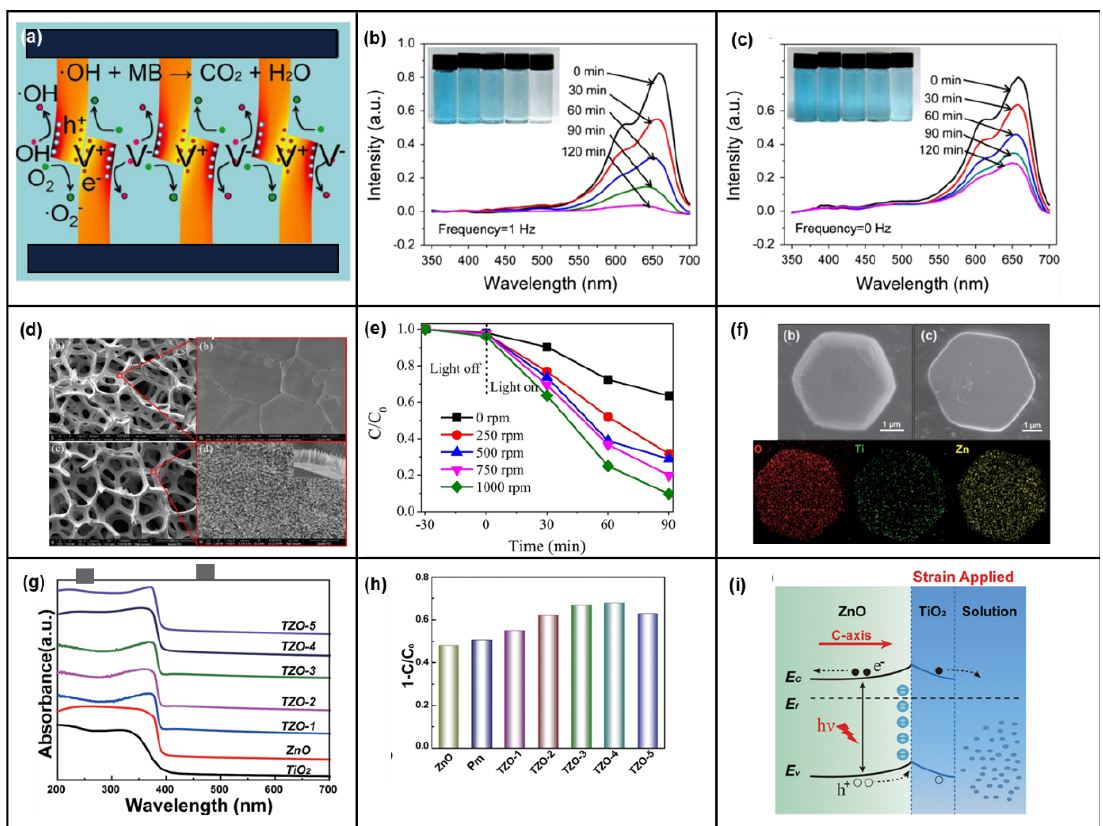
Figure 4. Schematic diagram of piezoelectric enhanced photocatalytic ZnO NW device and UV-Vis absorption spectroscopy. ( a ) Working mechanism of piezoelectric photocatalytic activity of